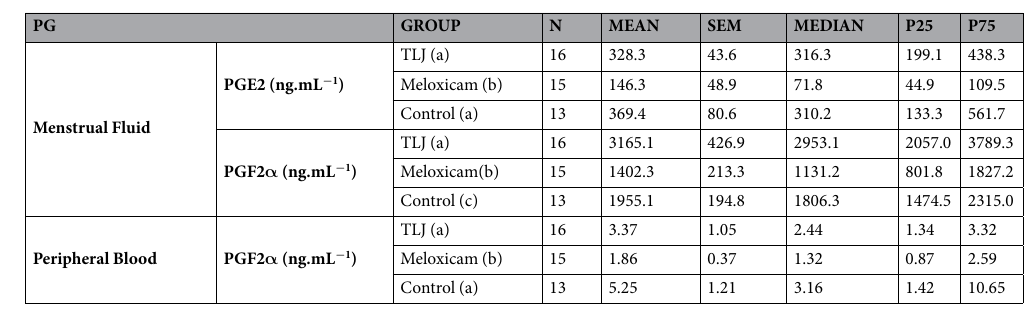
Table 2. Comparison of the concentrations of the prostaglandins E2 and F2 α present in the menstrual fluid and the peripheral serum from volunteers from the TLJ, Meloxicam and Control groups. Legend: SEM - Standard Error Mean, P25 - 25% percentil, P75 - 75% percentile, The letters (a), (b) and (c) represent groups considered statistically different. Statistical tests: Kruskal-Wallis and Dunn for multiple comparisons. PGE2 values from all peripheral blood samples were below the sensibility of the ELISA